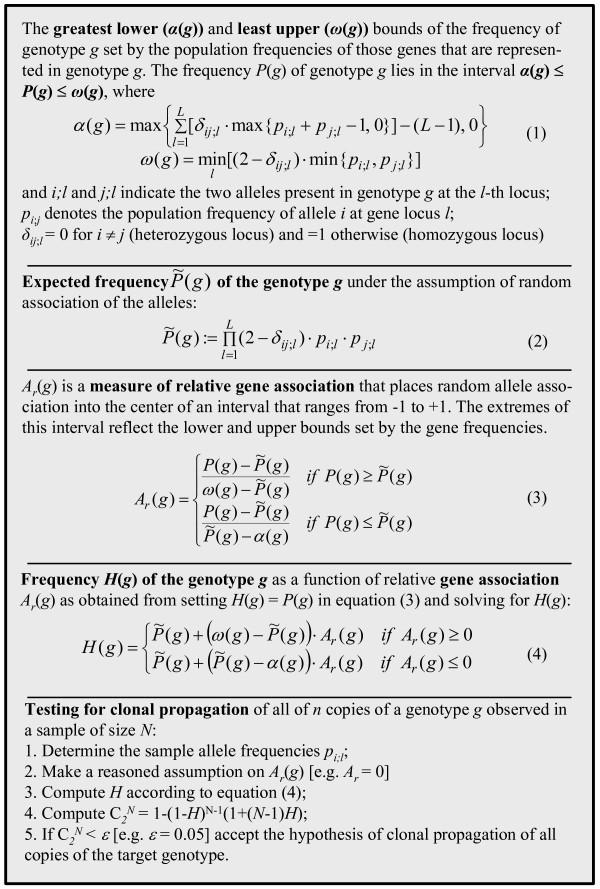
The statistical basis for testing asexual vs. sexual propagation considering gene associations (according to [10], changed).